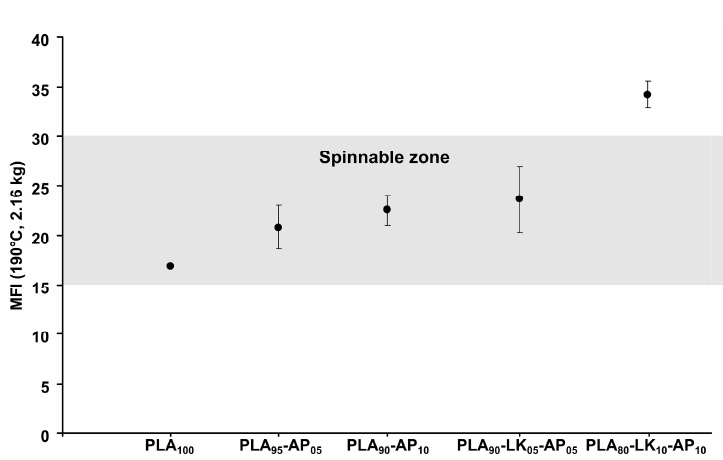
Figure 6. Melt flow index (190 °C, 2.16 kg) of PLA, PLA-AP and PLA-LK-AP pellets. Table 7. Results of cone calorimeter test for the knitted fabrics (25 kW.m − 2 ).